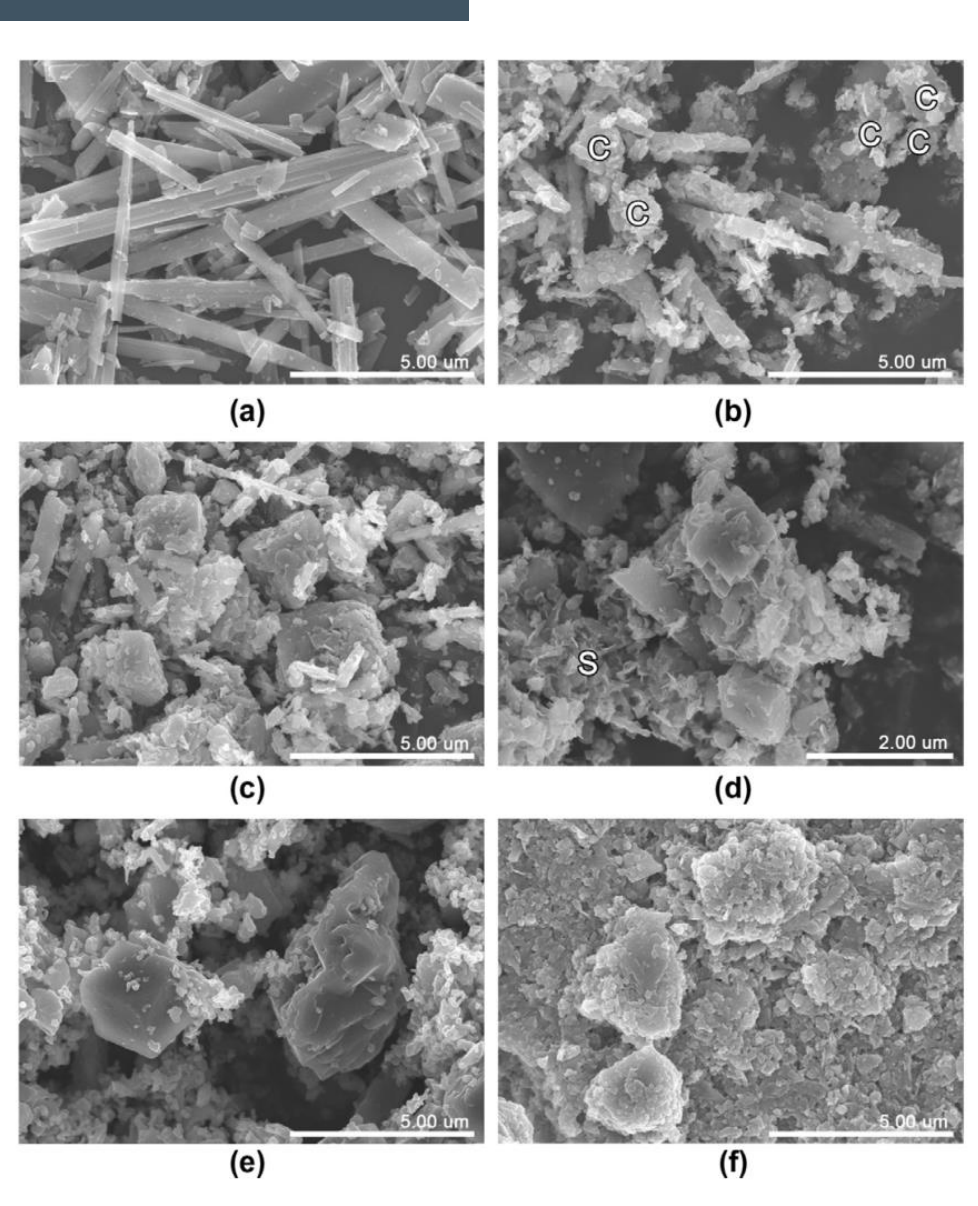
Figure 4. Evolution of tremolite carbonation: (a) acicular tremolite; (b) development of ¡1 µ m-sized calcite after 5 min of reaction; (c) image after carbonation for 15 min; (d and e) the shape of most of the tremolite grains changed to round and calcite shows euhedral morphology. The calcite with rhombohedral cleavage was surrounded by saponite of the ”curled flake type” after reaction for 1 h. (f) The edge of calcite was eroded by partial dissolution during the reaction for 5 h. C and S indicate calcite and saponite, respectively. Reprinted from Applied Geochemistry, Vol. 26, Ryu et al. [84], 1215-1221, Copyright 2011, with permission from Elsevier.